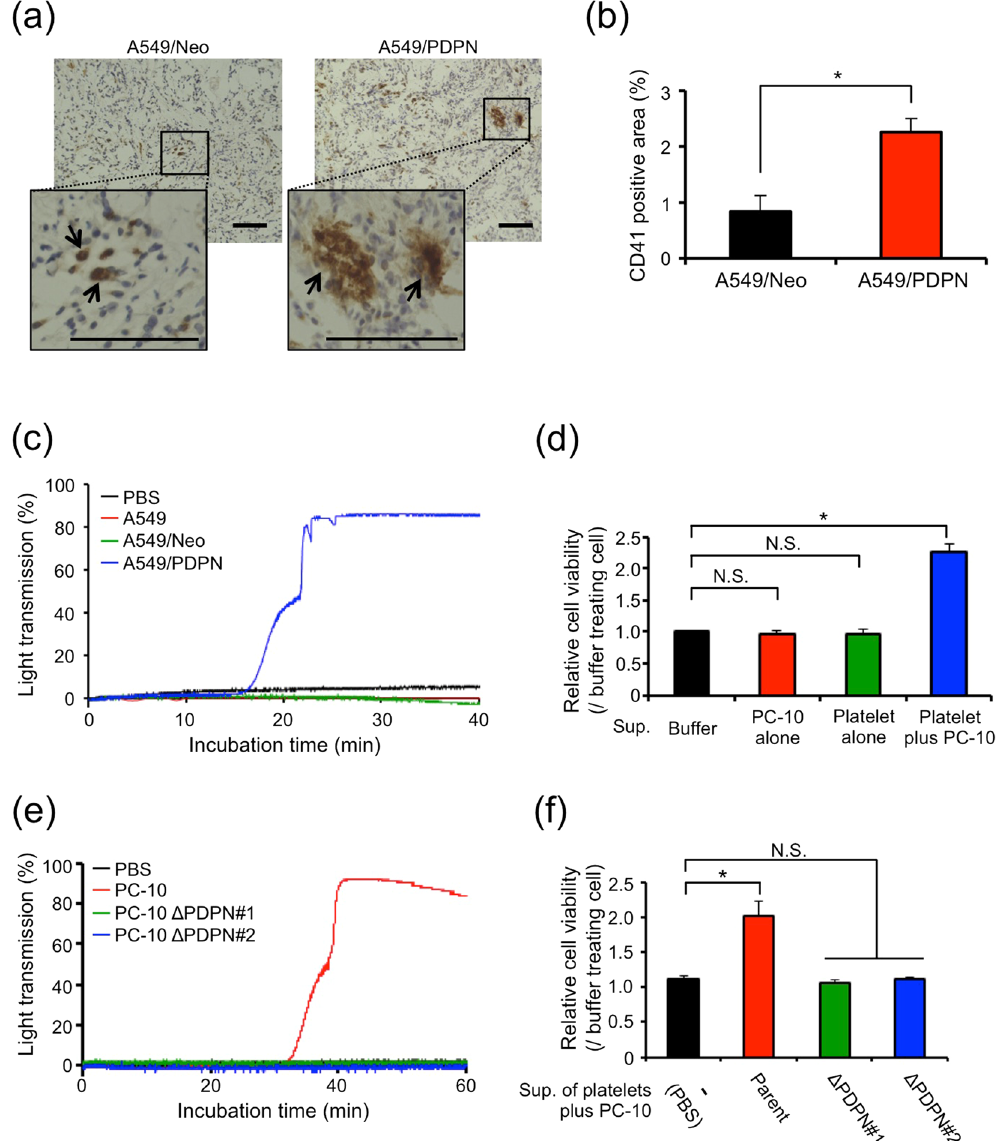
Figure 2. Podoplanin promotes cell growth by enhancing soluble factor secretion from platelets. ( a , b ) A549 cells that had been transfected with pcDNA3-mock (A549/Neo) or pcDNA3-podoplanin (A549/ PDPN) plasmid (5 × 10 6 cells) were subcutaneously injected into nude mice (N = 3). After 14 days of tumour inoculation, the tumours were extracted and stained with antibodies to CD41 ( a ). Arrows indicate platelet aggregates. Scale bar: 100 μ m. The CD41-positive area was quantitated from 3 independent fields for each mouse ( b ). All data are shown as means ± SEM. (N = 3) * P < 0.05 by Mann–Whitney U -test. ( c ) A549/Neo or A549/PDPN cells (2 × 10 6 cells/ml) were incubated with washed platelets (5 × 10 8 /ml) in Tyrode’s buffer containing 2% murine platelet-poor plasma and 250 μ M CaCl 2 . The light transmission was measured by MCM HEMA TRACER 313 M to monitor the platelet aggregation rate. ( d ) Supernatants were collected from buffer alone, platelets alone, PC-10 alone, or platelets incubated with PC-10 cells. Then, the PC-10 cells that had been transfected with ZsGreen gene (PC-10/ZsG) were cultured for 72 hours in each supernatant under 0.5% FBS condition. The cell viability of the PC-10/ZsG was calculated from ZsGreen fluorescence. All data are shown as means ± SD of triplicate experiments. * P < 0.05 by Mann–Whitney U -test. N.S.: Not significant. ( e ) PC-10 and podoplanin-knockout PC-10 (PC-10 Δ PDPN#1 and PC-10 Δ PDPN#2) cells (1 × 10 6 cells/ml) were incubated with washed platelets (5 × 10 8 /ml) in Tyrode’s buffer containing 2% platelet-poor plasma and 250 μ M CaCl 2 . The light transmission was measured by MCM HEMA TRACER 313 M to monitor platelet aggregation rate. ( f ) Supernatants were collected from platelets incubated with PC-10 (parent), PC-10 Δ PDPN#1 or PC-10 Δ PDPN#2 cells. Then, PC-10/ZsG cells were cultured with the collected supernatants under 0.5% FBS condition. After 72 hours, the cell viability of the PC-10/ZsG was calculated from ZsGreen fluorescence. All data are shown as means ± SD of triplicate experiments. * P < 0.05 by Mann–Whitney U -test. N.S.: Not